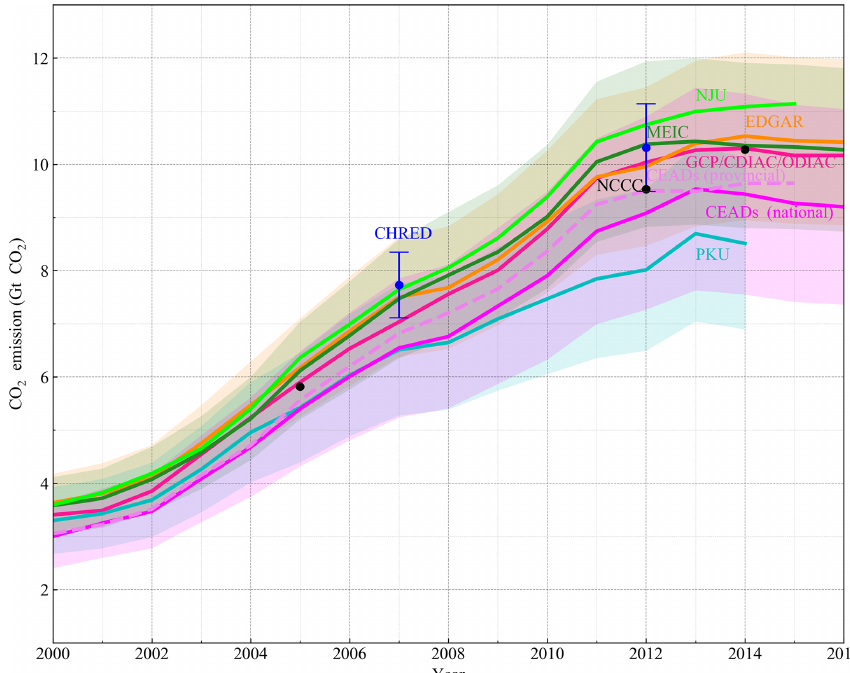
Figure 2. China’s total FFCO 2 emissions from 2000 to 2016. The emissions are from the combustion of fossil fuels and cement production from different sources (EDGARv4.3.2_FT2016 includes international aviation and marine bunker emissions). To maintain comparability and avoid differences resulting from emission disaggregation (e.g., Oda et al., 2018), the values of the six gridded emission inventories are tabular data provided by the data developers before spatial disaggregation. Prior to 2014, GCP data were taken from CDIAC, and those from 2015 to 2016 were calculated based on BP data and the fraction of cement production emissions in 2014. The shaded area (error bar for CHRED) indicates uncertainties from the coauthors’ previous studies (see Table